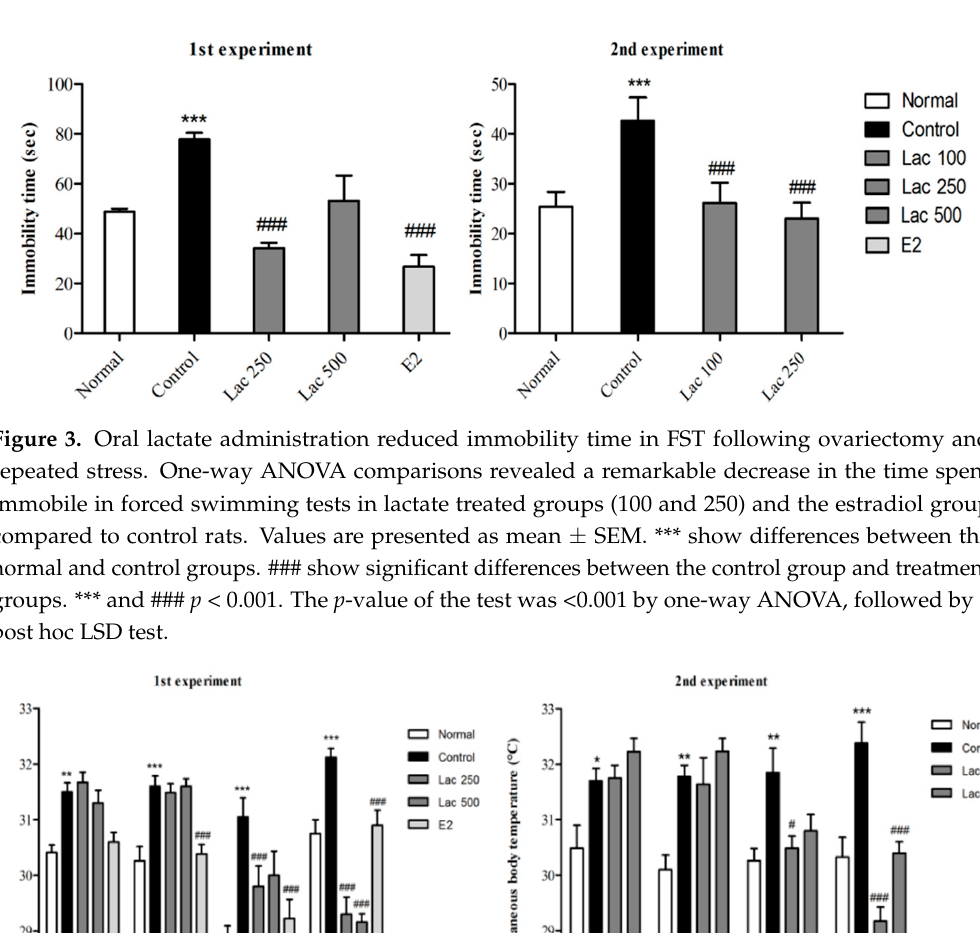
6 of 15 Figure 2. Effect of oral lactate administration on ovariectomized rats with stress in tail suspension tests (TST). Oral lactate administration (100 and 250) and estradiol decreased immobility time significantly compared to the control group. Values are presented as mean ± standard error of the mean (SEM). *** show the difference between the normal and control groups, while ### show significant differences between the control group and treatment groups. *** and ### p < 0.001. The p value of the test was < 0.001 by one-way ANOVA, followed by a post hoc LSD test. 3.2. Oral Lactate Administration Decreased Immobility Time in FST In both experiments, ovariectomized and stressed rats exhibited longer times spent immobile.